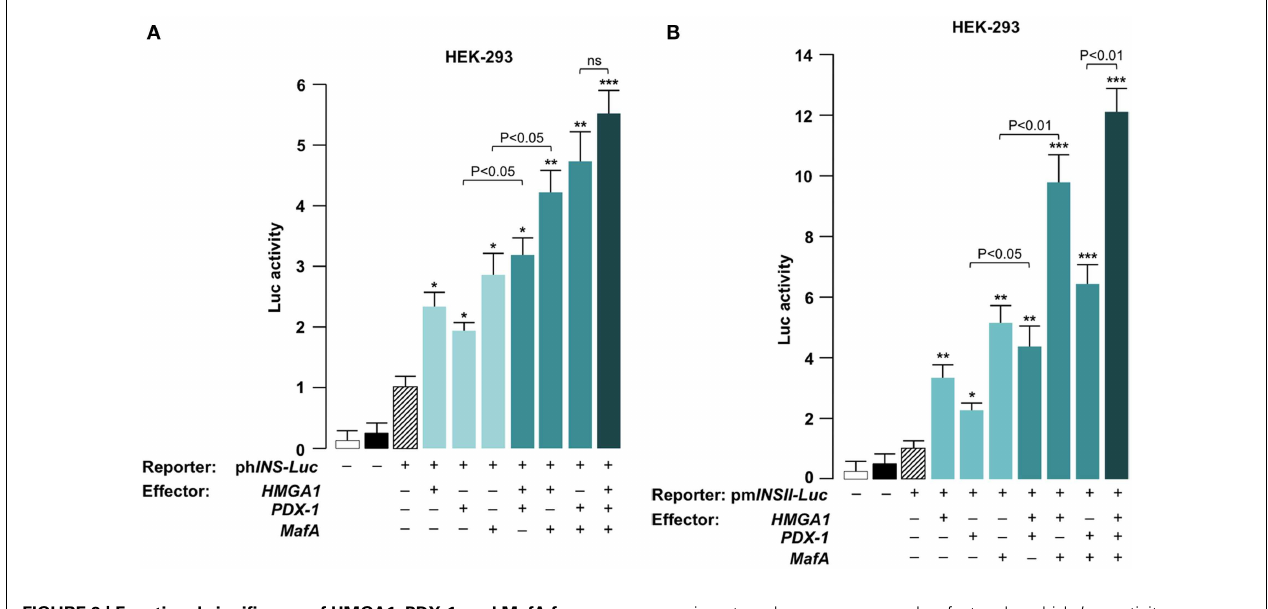
FIGURE 3 | Functional significance of HMGA1, PDX-1, and MafA for INS gene transcription . HEK-293 cells were cotransfected with 1 µ g of human (ph INS-Luc ) (A) or mouse (pm INSII-Luc ) (B) Luc reporter plasmids, in the absence or presence of effector vectors for HMGA1, PDX-1, and MafA (0.5 µ g each), either alone or in double or triple combinations. Data represent the means ± SE for three separate